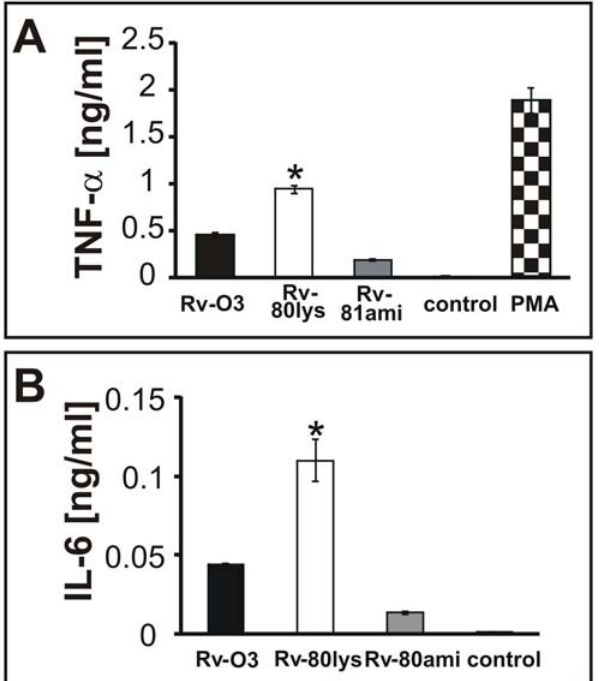
Figure 7. Select cytokine responses of macrophages. Panel A: MDMO were infected with Mtb strains, and TNF- a release was measured by ELISA. PMA was used as a positive control. TNF- a levels in panel A were measured after 24 h. * Represents P , 0.05 compared to Rv-03, Rv- 81ami, control (untreated cells) and PMA. Panel B: Secretion of IL-6 by MDMO after 48 h of infection. * P , 0.05 compared to Rv-03, Rv-81ami and control. The experiments were done in duplicate, and represen- tative results are shown. Data are mean 6 standard error. Student- Newman-Keuls Method was used.